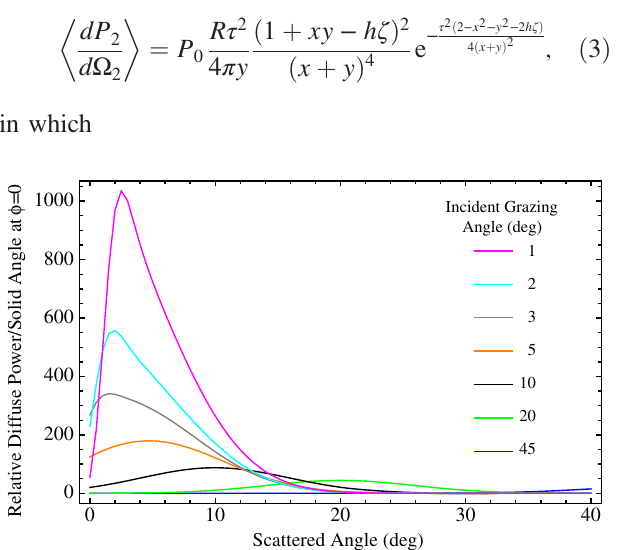
FIG. 5. Diffuse scattering polar angular distributions for 30 eV photons, σ ¼ 200 nm and T ¼ 5500 nm. The full diffuse scatter- ing expression [Eq. (A97)] has been used to calculate these curves.